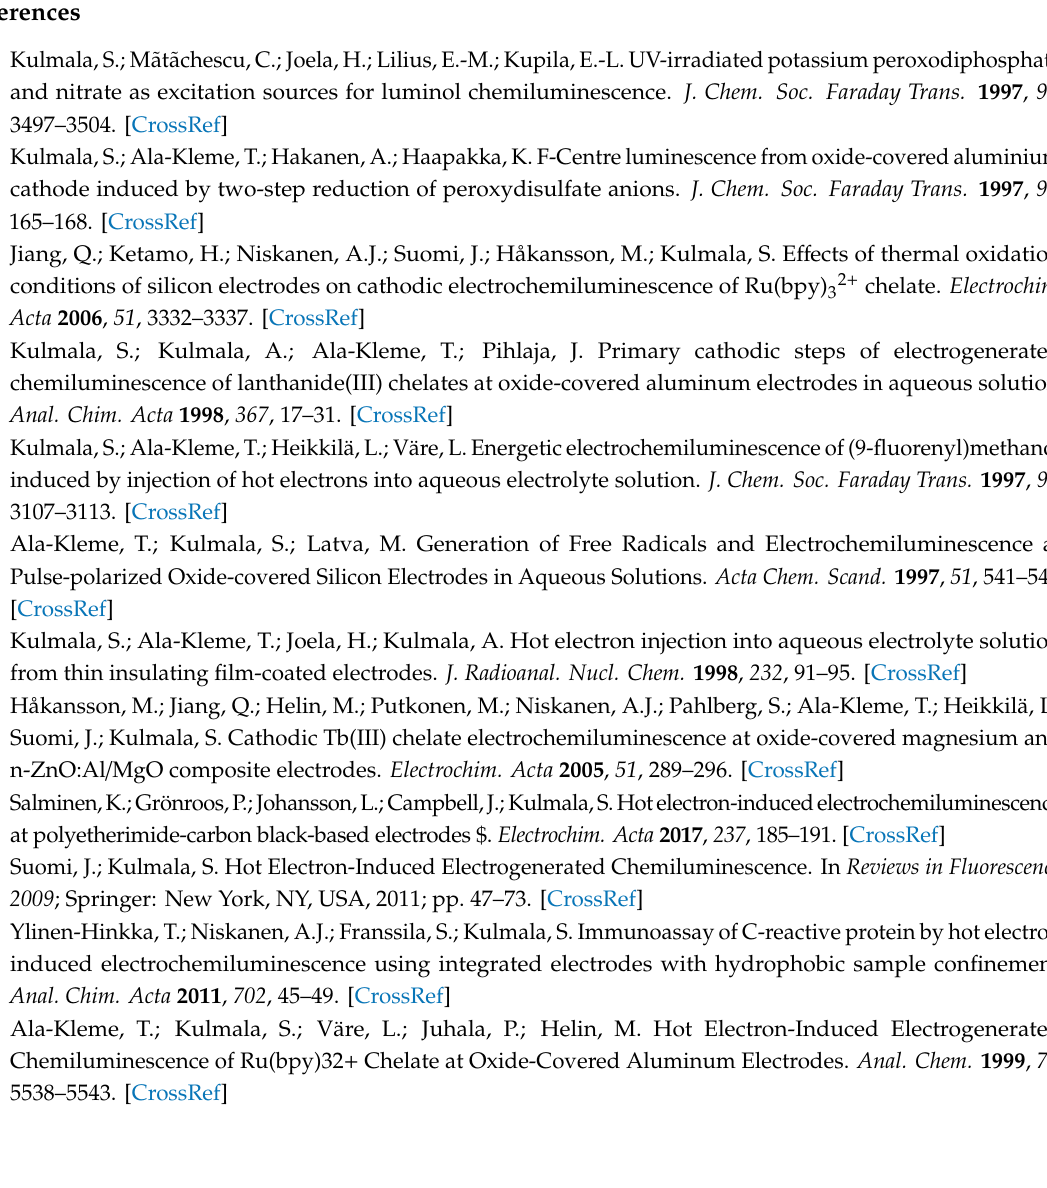
of surface morphology of RS PS-CB electrode, Figure S6: Long-exposure photographs of RS EC-CB electrodes with lower voltage and pulse charge, Figure S7: Long-exposure photographs of LF EC-CB electrodes with lower voltage and pulse charge, Figure S8: Long-exposure photographs of RS EC-CB electrodes with higher voltage and pulse charge, Figure S9: Tb(III)-1 HECL intensity as a function of voltage and charge. RS EC-CB and PS-CB electrodes, Figure S10: Tb(III)-1 HECL intensity as a function of ordinal number of excitation pulses, Figure S11: FITC calibration curves. LF EC-CB and PS-CB LF electrodes, Figure S12: FITC calibration curves. RS EC-CB and PS-CB LF electrodes, Figure S13: Calibration curve of FITC under direct current excitation. RS EC-CB electrodes, Figure S14: CRP calibration curve, Tb(III)-2-labeled secondary antibody. RS EC-CB and RS PS-CB electrodes, Figure S15: CRP calibration curve, FITC-labeled secondary antibody. LF EC-CB electrodes. Author Contributions: The conceptualization, methodology, and writing were performed by P.G. (main